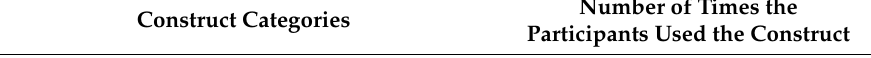
Number of Times the Participants Used the